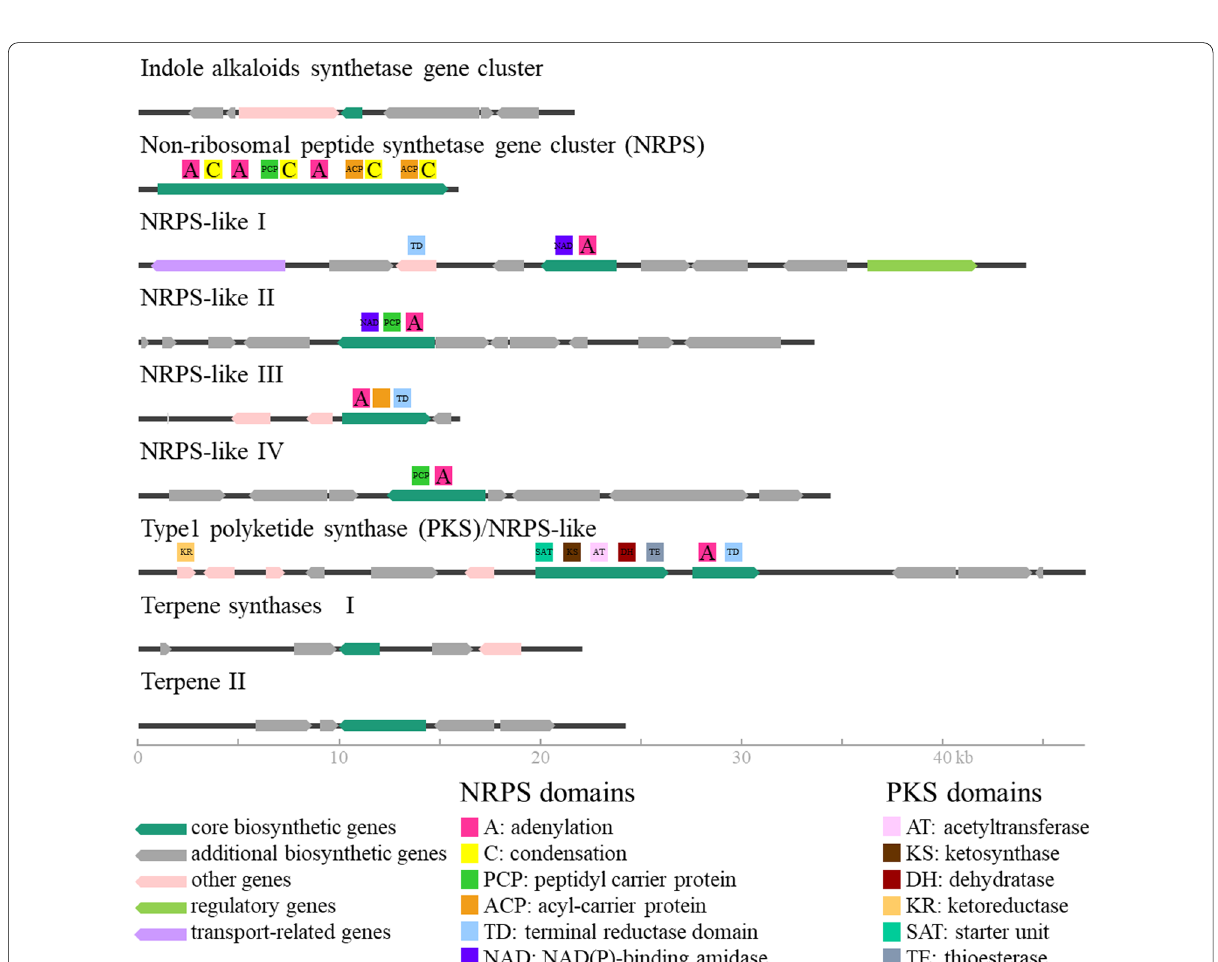
Fig. 6 The gene organization of the nine putative secondary metabolite gene clusters found in all 16 T . caries , T. controversa , and T. laevis